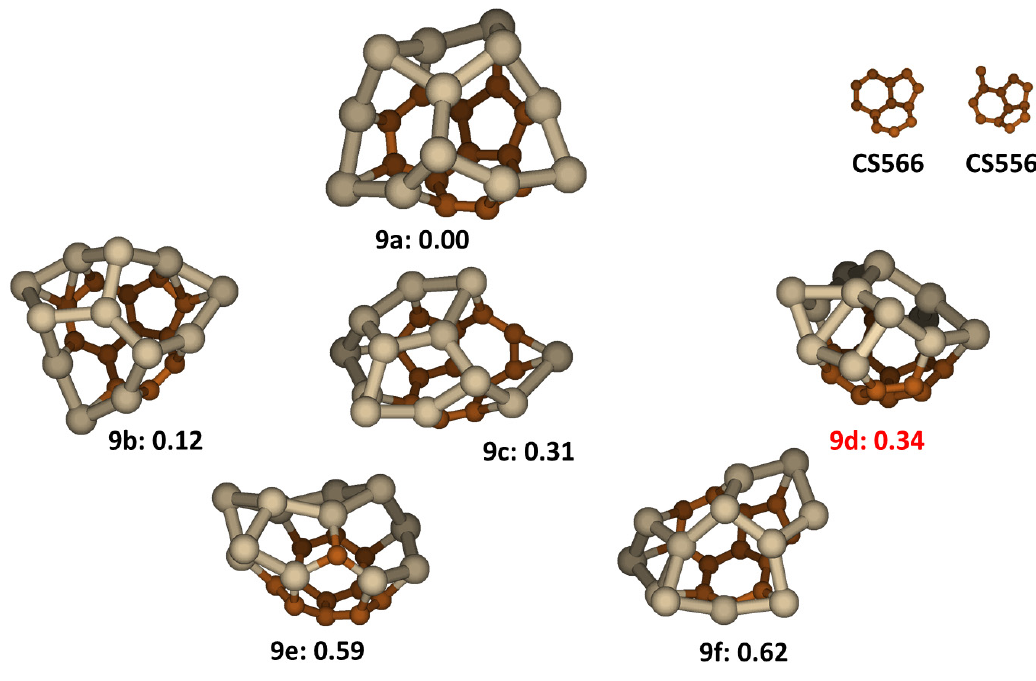
Figure 9. The structures and relative energies (in eV) of the lower energy Si and carbon segregations. Structure 9d is previously reported in ref.